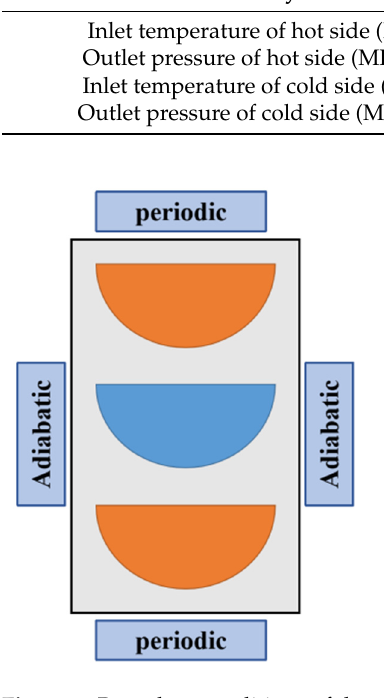
Figure 5. Boundary conditions of the walls.